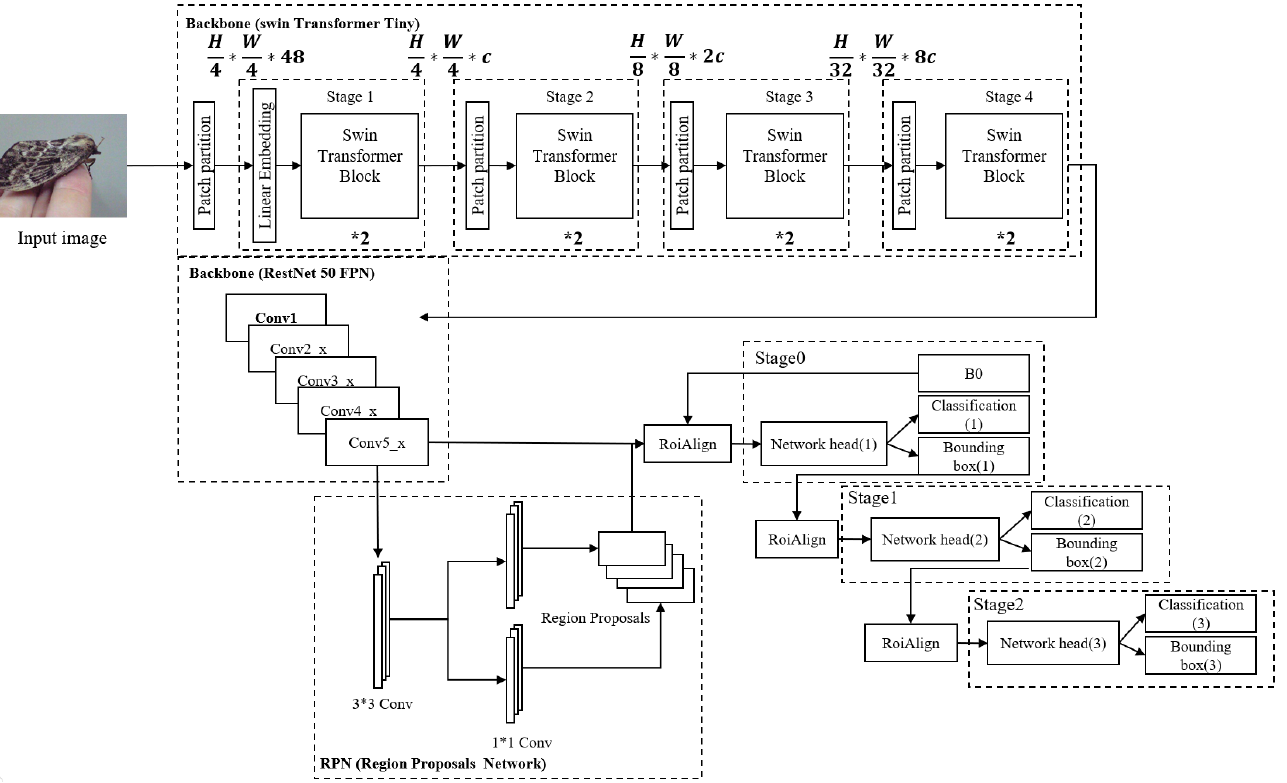
Figure 6. Design of a mixed model composed of the Swin Transformer model and the Cascade R- CNN model. R-CNN